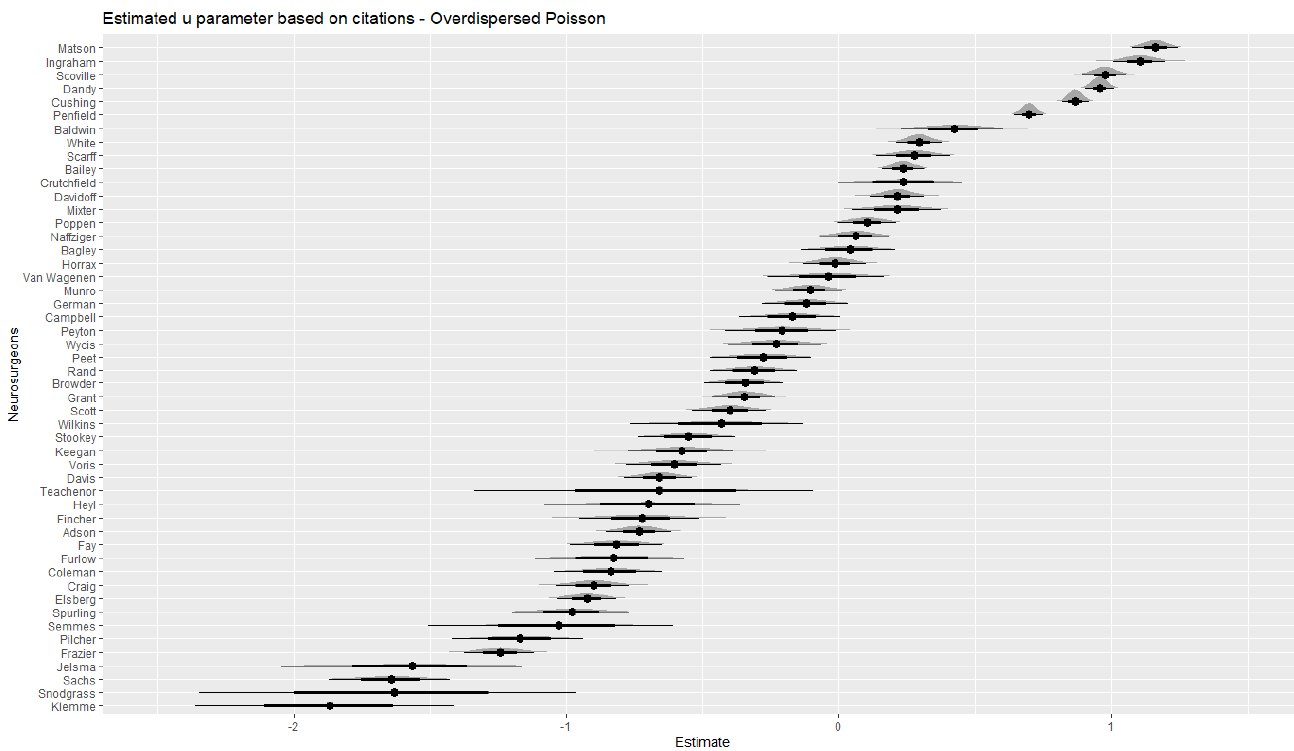
Figure 2. Estimated individual deviations from the overall hit rate obtained from the overdispersed Poisson model for citations.